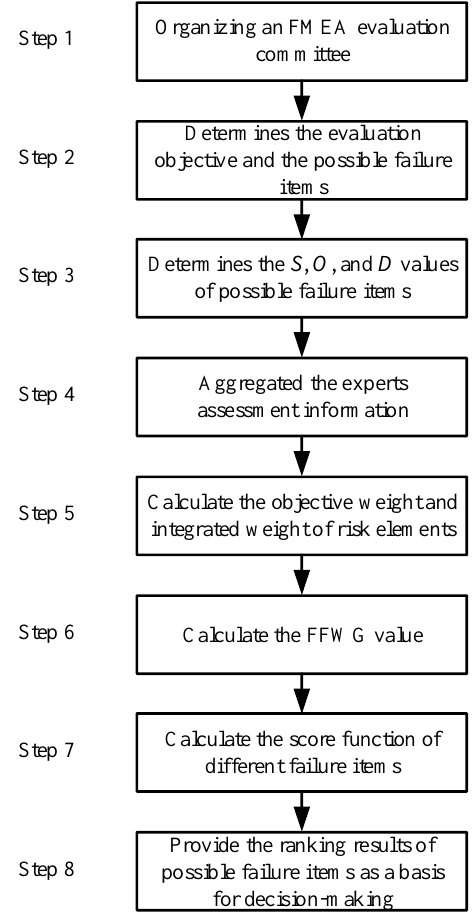
Figure 1. The flow chart of the proposed hybrid FFS and entropy method.